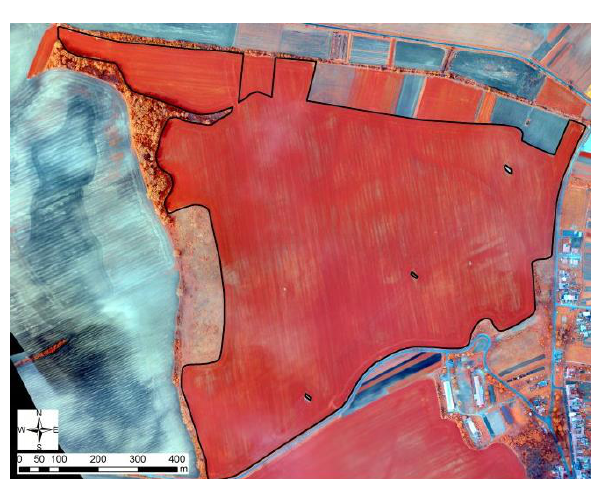
Figure 2. Orthomosaic of the experimental field from UAV survey in the false color representation